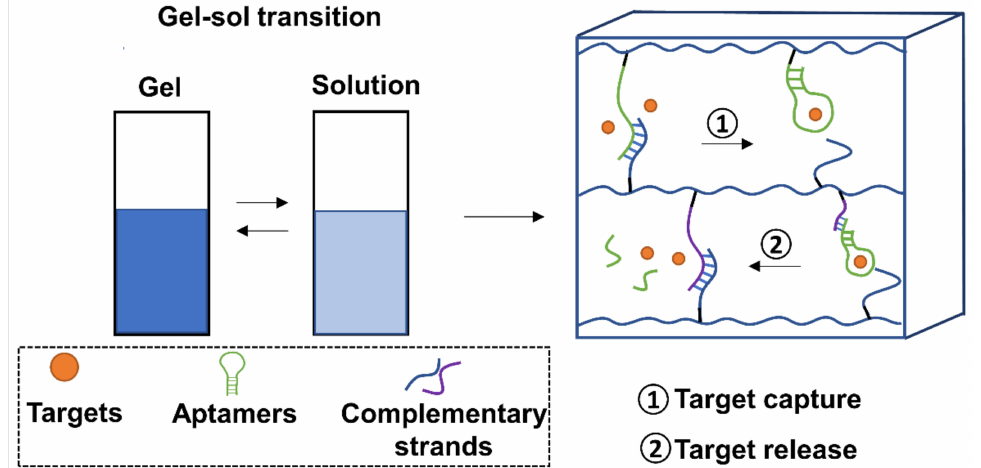
Figure 5. Schematic representation of the gel-sol transition of aptamer-decorated hydrogels. For target capture, aptamers in hydrogels would be de-hybridized from complementary strands to capture targets. For target release, aptamer-captured targets are released via a competitive hybridization from complementary oligonucleotides of aptamers or aptamer